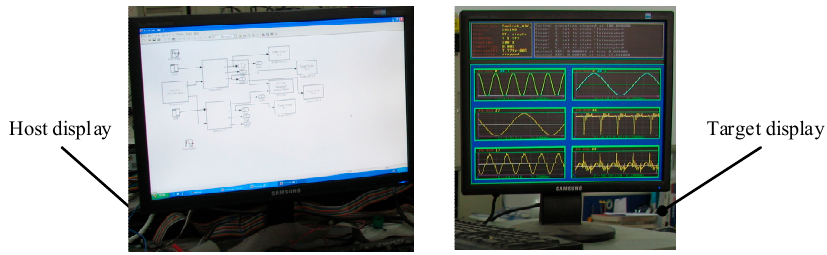
Figure 9. The display of the RTW real-time experiment platform.